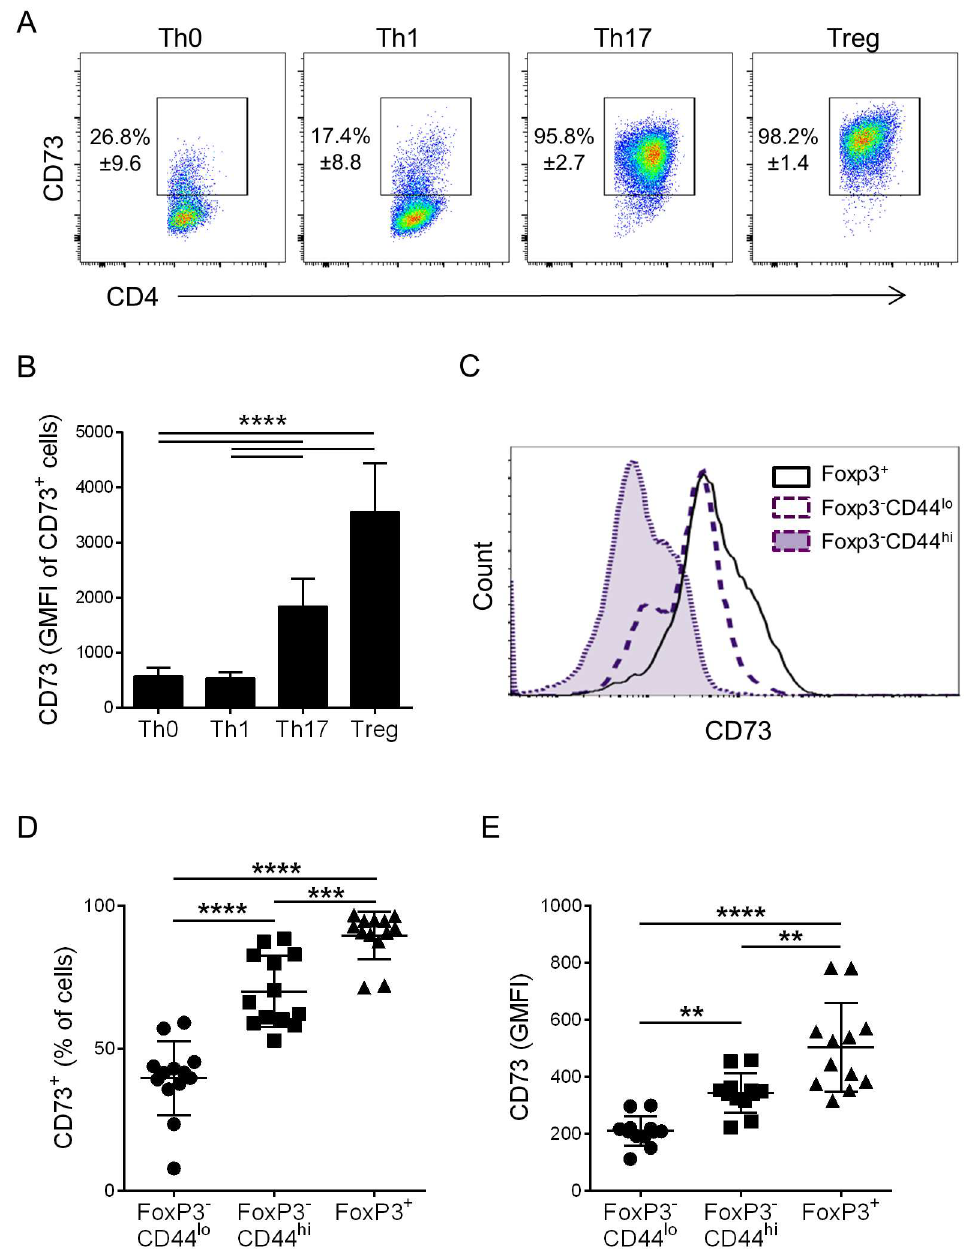
Fig 1. CD73expression on T helper cells in vitro and in vivo . A: CD73 expressionon indicatedlive CD4 + T helpercell subsets after three days of ulture in vitro , numbers indicatemean % +/- S.D. from three separate experiments. B: Mean level of CD73 expressionmeasuredas Geometric Mean Fluorescence Intensity of gated live CD4 + CD73 + cells, from three experiments. C: Representative histogram of CD73expressionby Tregs (FoxP3 + ), na ï veT cells (FoxP3 - CD44 lo ), or effector/memory (FoxP3 - CD44 hi ) T cells in LN from na ï veC57BL/6 mice. D: Mean percentageof CD73 + cells and E: CD73Geometric Mean Fluorescence Intensity of populations indicatedin C; data pooledfrom 4 independent experiments (each point represents a separatemouse). Error bars indicate S.D.